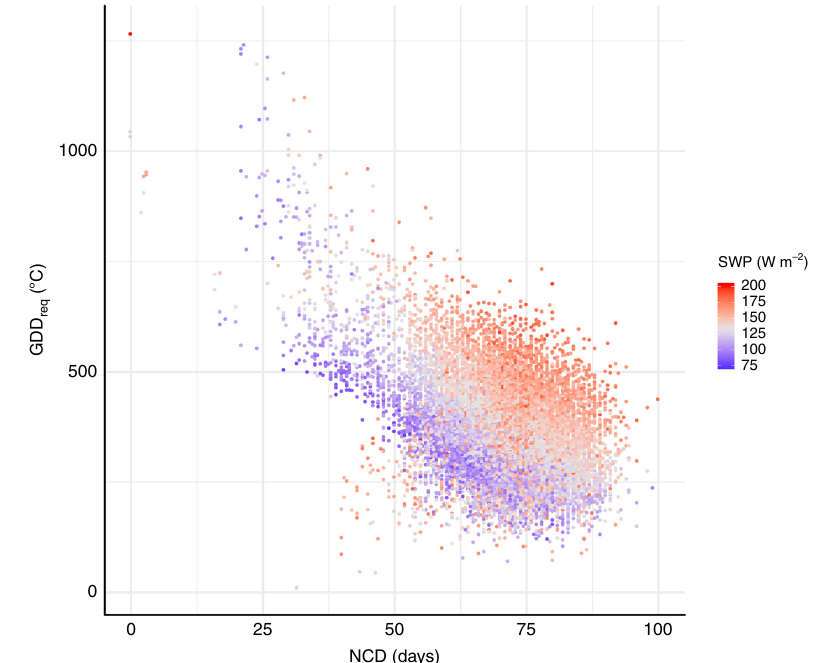
Fig. 4 Adaptation of chilling-forcing requirement to preseason radiation. Scatterplot of average site long-term (1970 – 2016) GDD req (°C) versus NCD (days) for all species and all sites. The color gradient represents the average site long-term incoming shortwave preseason radiation (SWP, W m − 2 ). Gray color represents the median value of SWP (130 W m − 2 ) of all sites, blue and red colors correspond to values lower and higher than the median SWP, respectively. Source data are provided as a Source Data fi